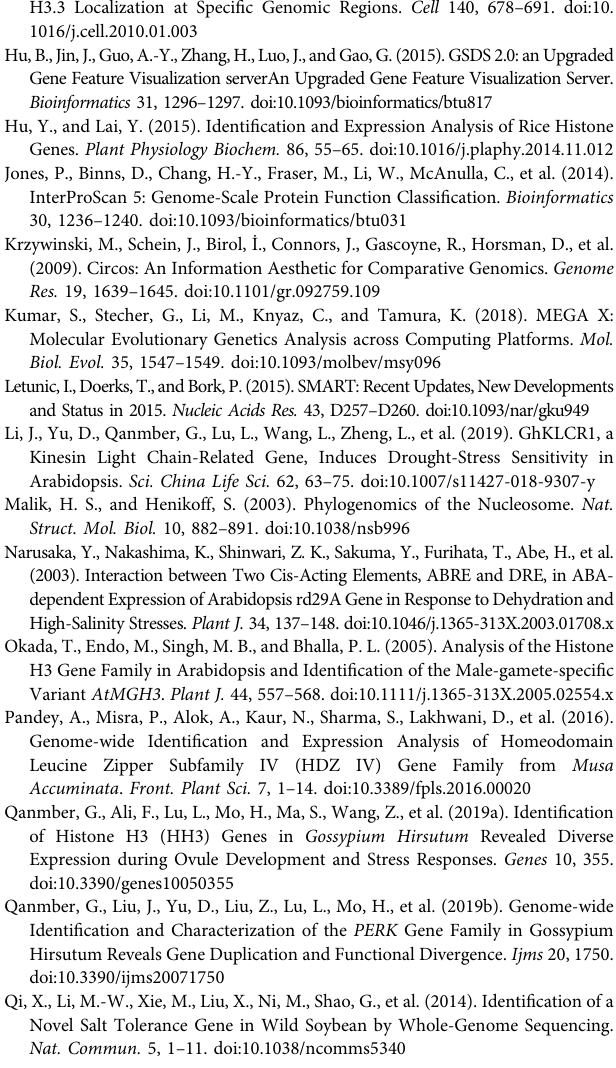
Supplementary Table 6 | cis-elements in